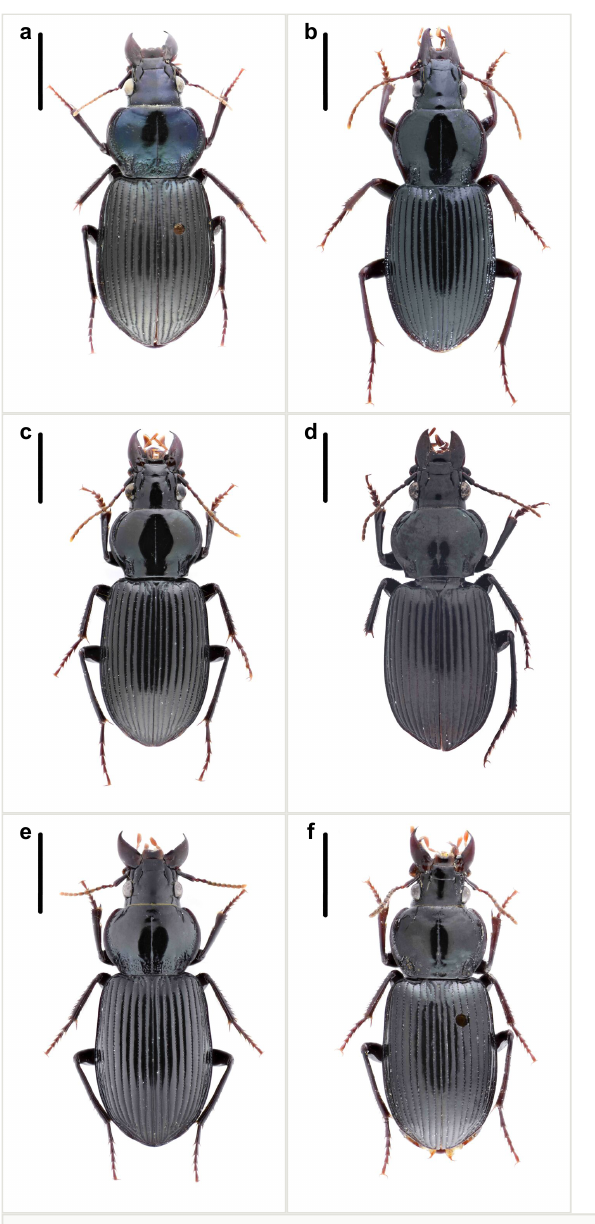
Figure 1. Habitus of Pareuryaptus spp. from China (scale bars = 3 mm): a , P. adoxus (Tschitschérine), female from Danuoyou, Yunnan; b , P. exiguus Dubault, Lassalle & Roux, male from Naqin Village, Guangxi; c , P. luangphabangensis Kirschenhofer, male from Nanpaxiaozhai, Yunnan; d , P. luangphabangensis Kirschenhofer, male from Jino Mt., Yunnan (taken by Xiaoran Yang); e , P. chalceolus chalceolus (Bates), female from Hanjiang, Fujian; f , P. chalceolus formosanus (Jedli č ka), female from Jialeshui,